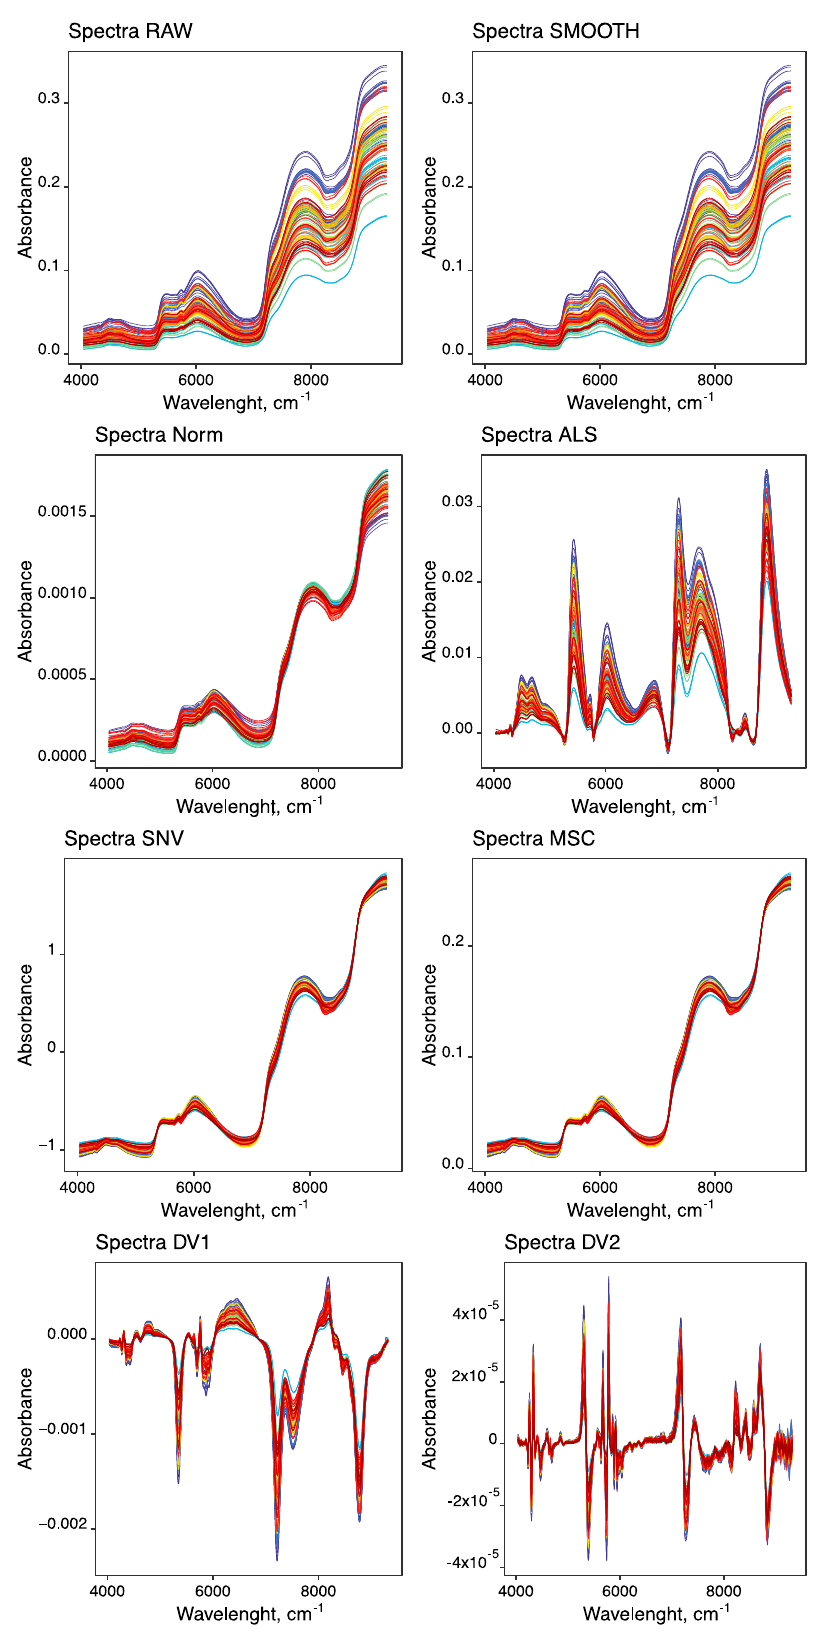
Figure 2. Representation of all raw, smoothed, NORM-SMT, ALS-SMT, SNV-SMT, MSC-SMT, DV1 and DV2 mean spectra obtained from the 40 samples of LTL